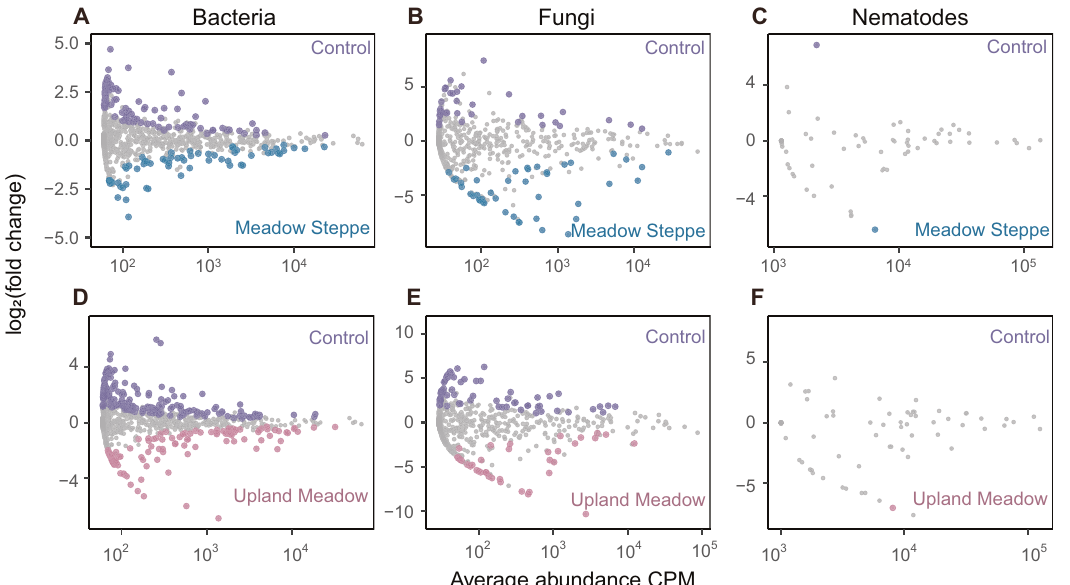
Fig. 5 Soil inoculation effects on speci fi c sets of bacteria, fungi and nematodes. Abundance patterns of meadow steppe soil inoculation treatments in bacterial ( A ), fungal ( B ) and nematode ( C ) communities (blue) and of upland meadow soil inoculation treatments in bacterial ( D ), fungal ( E ) and nematode ( F ) communities (pink) in comparison with the control (purple). The X-axis shows average abundance CPM (counts per million), and the Y-axis shows log 2 (fold change) (control relative to meadow steppe inoculation or upland meadow soil inoculation). Blue, pink and purple points showed speci fi c genera in meadow steppe, upland meadow and control respectively, and non-differential genera are colored in gray (likelihood ratio test, P < 0.05, FDR